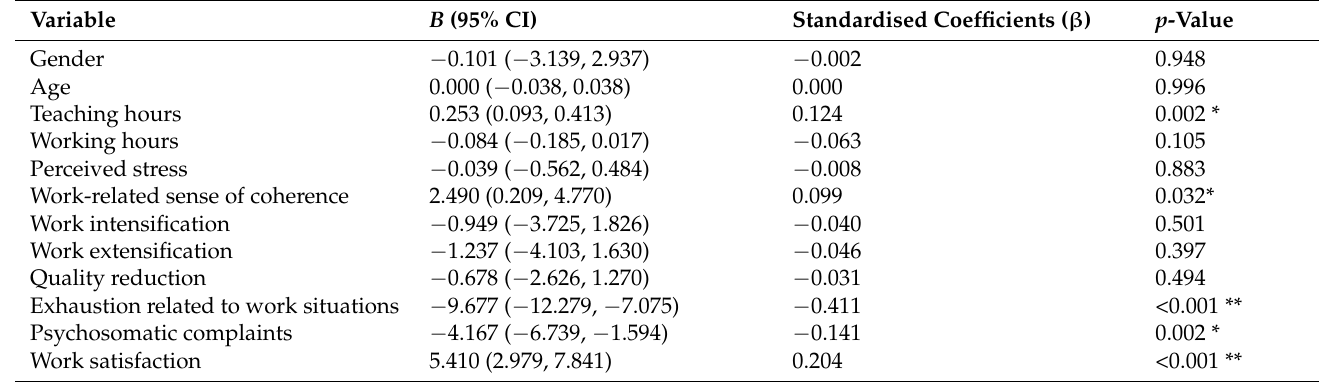
Table 5. Regression model for predicting teachers’ well-being score.